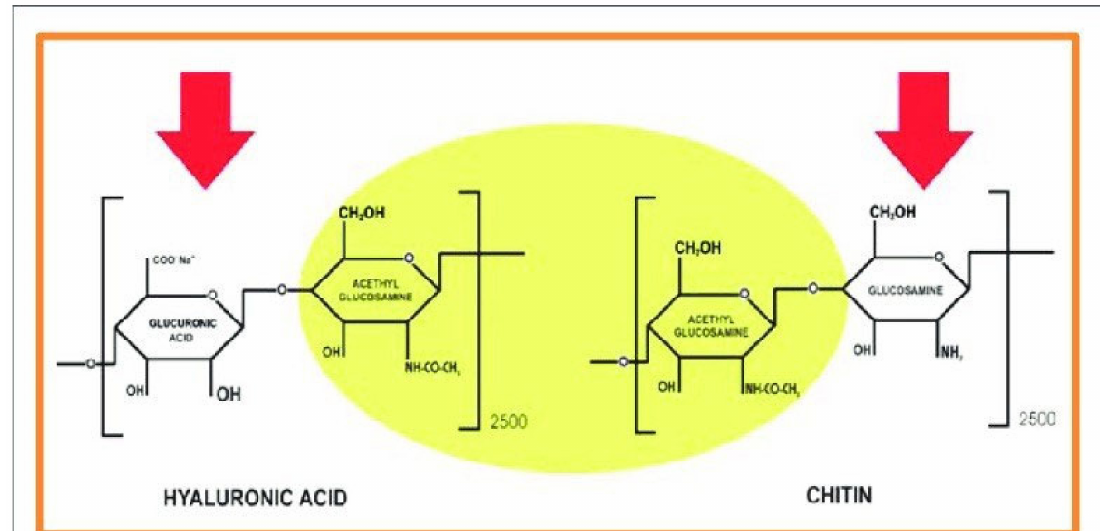
Figure 1. Backbone of hyaluronic in comparison with chitin.